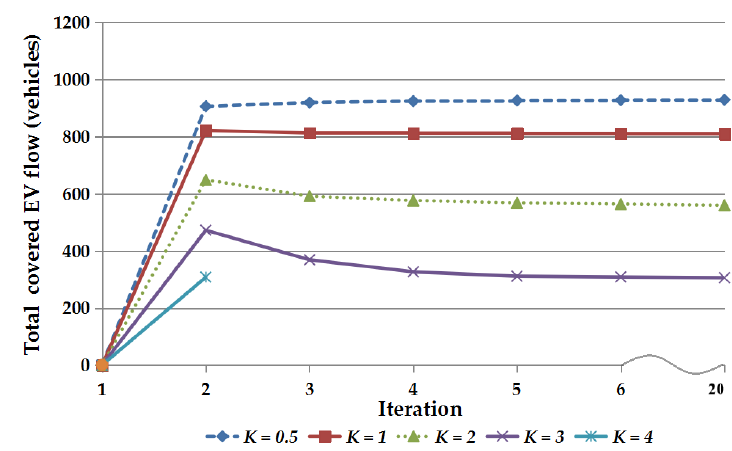
Figure 8. The sensitivity analysis of waiting cost coefficient K